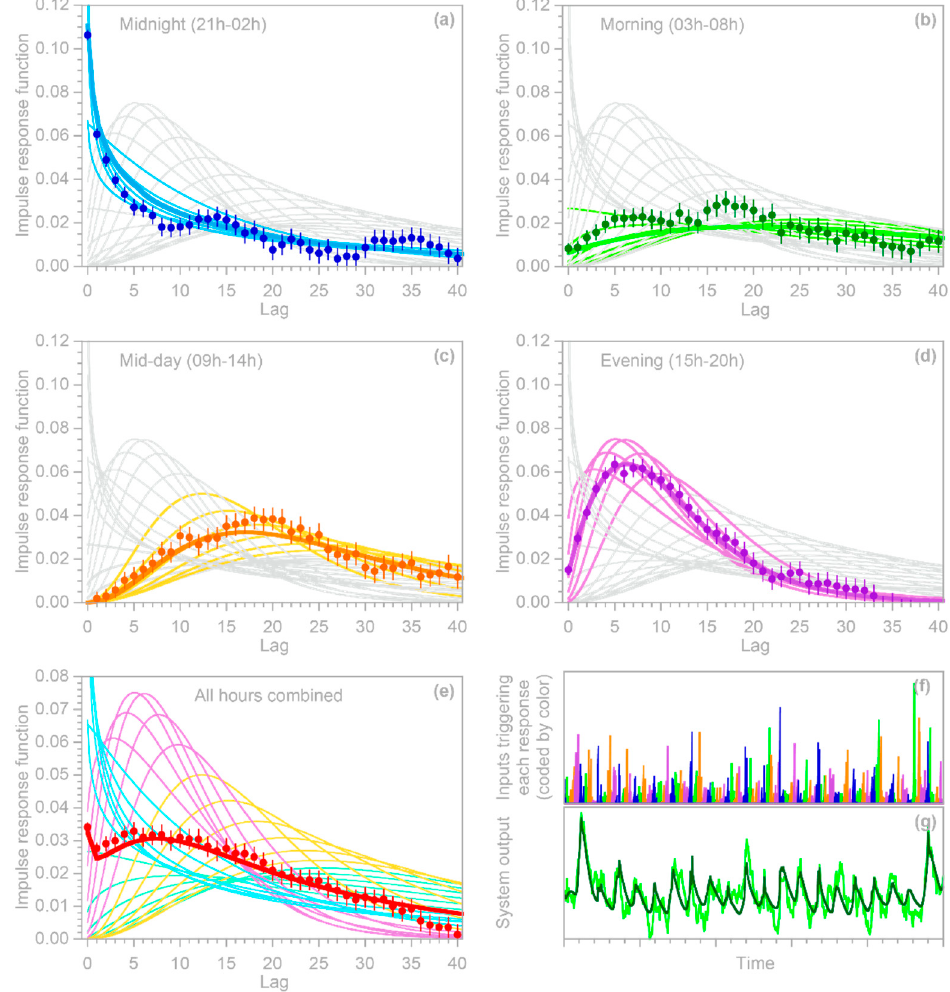
Figure 7. Benchmark test with a nonstationary system whose impulse response varies with time of day. Impulse responses for each hour are shown by the thin lines. These are grouped into four six ‐ hour periods, as shown by the colored lines in ( a – d ), with the average impulse responses for each six ‐ hour period shown by the thicker and slightly darker colored lines. The inputs to the benchmark system are random ( f ), but lead to an irregular daily cycle in the output ( g ), owing to the sharper impulse response during night ‐ time ( a ). Using only the input shown in ( f ) and the ARMA ‐ noise ‐ corrupted output shown in light green in ( g ), the 𝐼𝑅𝐹 routine yields the solid circles shown in ( a – d ), which exhibit broadly similar patterns to the average impulse responses for the corresponding times of day (thicker colored lines). Alternatively, if one treats the system as if it is stationary (by ignoring the differences among the colored input times in ( f ), the 𝐼𝑅𝐹 routine yields the solid circles shown in ( e ), which correspond closely to the ensemble average (thick red curve) of the hourly im ‐ pulse responses (thin lines). Error bars in ( a – e ) indicate 1 standard error. Noise in ( g ) is ARMA(1,2), with an AR coefficient of 0.9 and MA coefficients of − 0.2 and +0.2, added to the true system output at a signal ‐ to ‐ noise ratio of 1. Panels ( f ) and ( g ) show 500 time steps, equaling five percent of each time series. 4.3. Average Impulse Response of Nonstationary Systems Many nonstationary systems may not be recognized as such, and may be analyzed as if they were stationary instead. It is worthwhile to ask what the outcomes of such anal ‐ yses are likely to be. What will be the apparent stationary IRF of the system? Additionally, will this resemble, or differ from, the average of the system’s nonstationary IRFs?